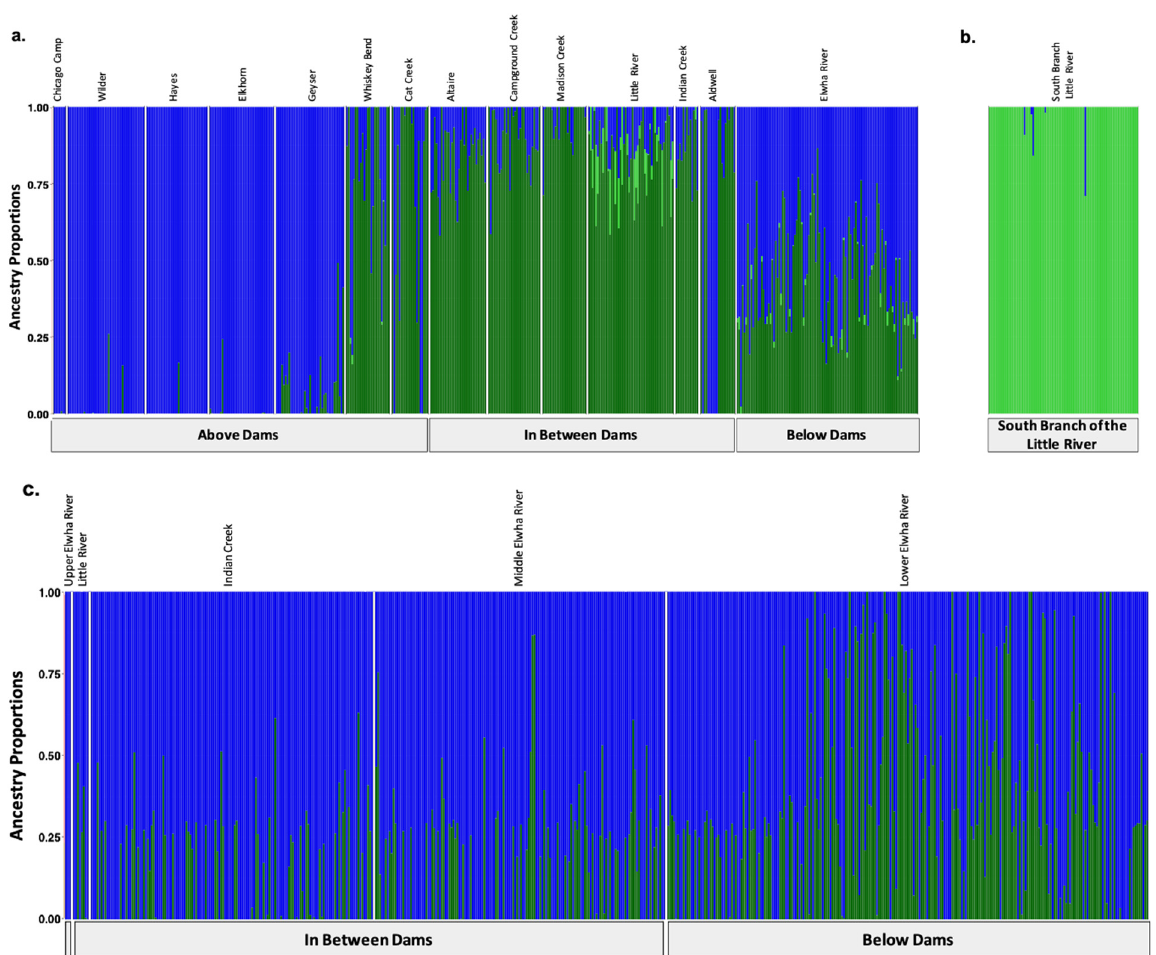
Figure 3. Population assignments computed by fastSTRUCTURE for samples collected ( a , b ) prior to dam removal supported three distinct genetic clusters (K = 3). ( a ) High levels of genetic structure were observed among populations split by man-made barriers such as dams ( b ) as well as natural barriers, such as the waterfalls that separate the South Branch of the Little River from the Little River. ( c ) Post-dam removal, we detected two genetic clusters with increasing levels of admixture. Each colored vertical bar represents a single individual sampled at one of the sampling sites labelled across the top x axis, organized from up-river to down-river and divided by anadromous barrier location, as labelled on the bottom x axis. The left-most samples in the plot, denoted by an unlabeled, empty gray box, include samples from above the dams, furthest up-river. Each color represents a distinct genetic cluster.